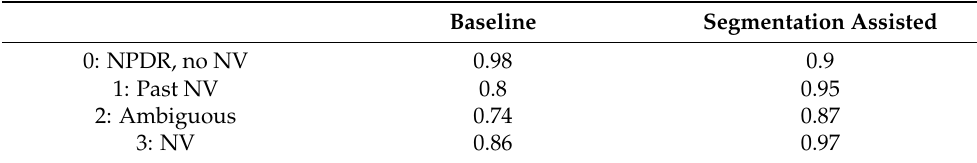
Table 2. Area under the ROC curves (AUC) values for DR classification